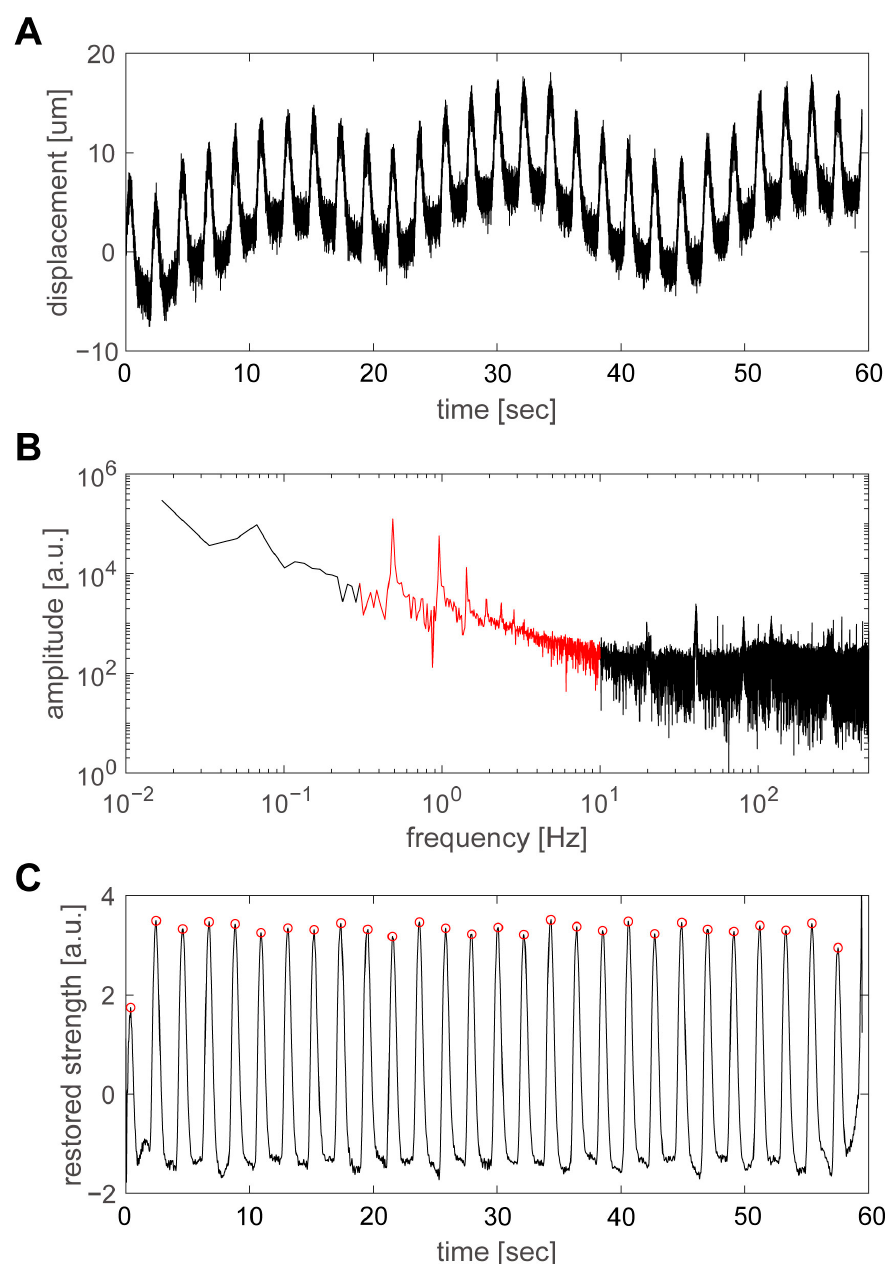
Figure 5. Pulsation of group D at 24 ◦ C. ( A ) The signal (voltage) from the sensor was converted to displacement using the calibration data. ( B ) The spectrum obtained by applying FFT to the sensor signal. The main component of the pulsation, 0.3–10 Hz, is shown in red. ( C ) The time dependence, which was reconstructed by applying inverse FFT to the main component of the pulsation. The peaks of the pulsation were automatically detected and are indicated by the red circles.